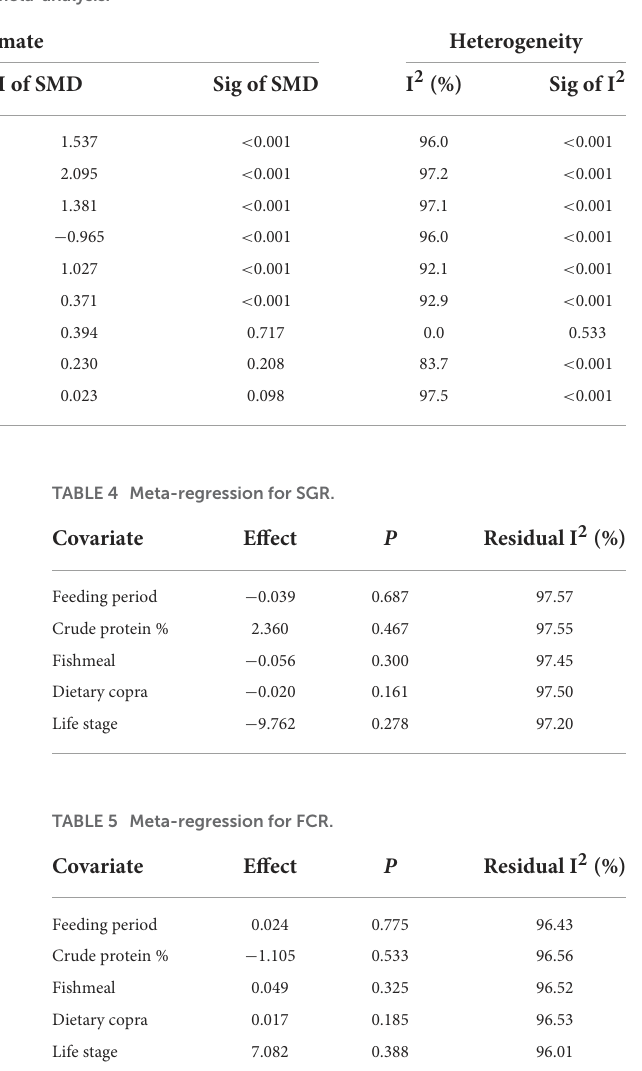
TABLE 1 Pooled estimate and heterogeneity of copra meal treatment meta-analysis.